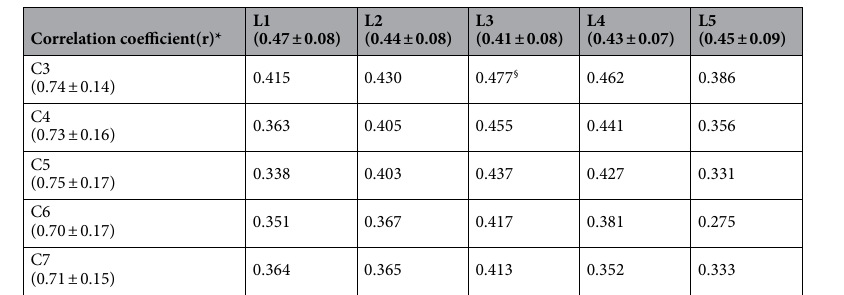
Table 2. Correlations between cervical and lumbar spinal canal-body ratios. All cervical canal-body ratios from C3 to C7 were correlated with lumbar canal-body ratios at all segments. Particularly, the C3 canal-body ratio showed highest correlation with L3 canal-body ratio. *All p value < 0.001, § highest correlation coefficient.